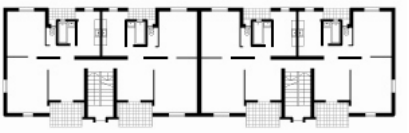
Figure 4: a common public housing floor plan.